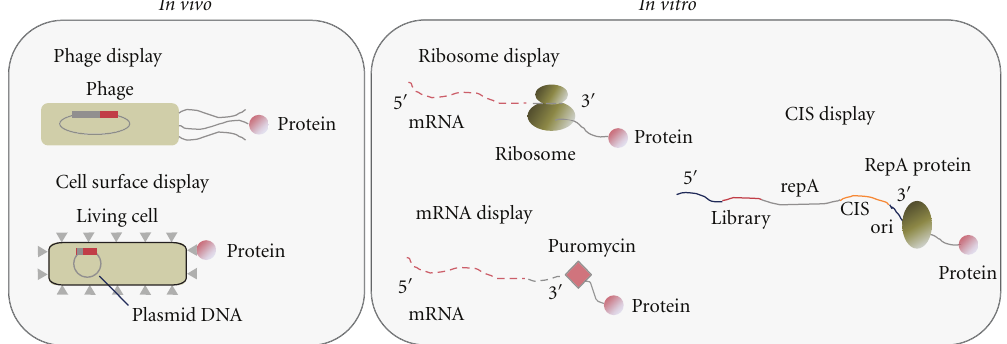
Figure 1: Genotype (genetic information)-phenotype (protein synthesized from the gene and its function) linkage and screening techniques for directed evolution of proteins. Screening techniques are categorized as in vivo and in vitro approaches.